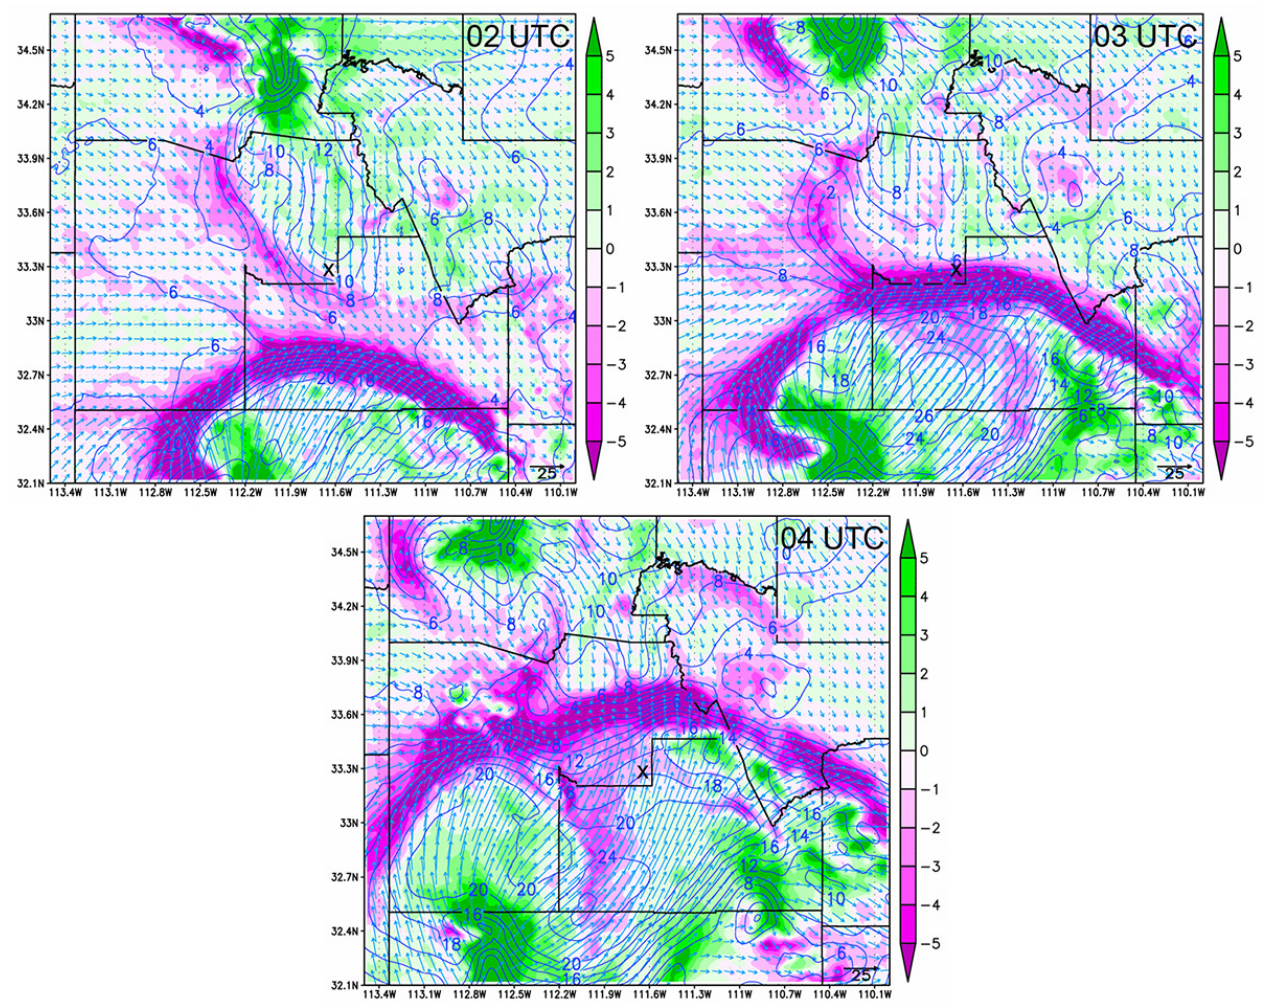
Fig. 4. NMME–DREAM wind at 11th model level ( ∼ 500m), divergence in 10 − 4 s − 1 (green to purple), magnitude in m/s (blue lines), and direction (arrows) at 02:00 (upper left), 03:00 (upper right), and 04:00 (lower) UTC, respectively, 6 July 2011; radar location is marked with